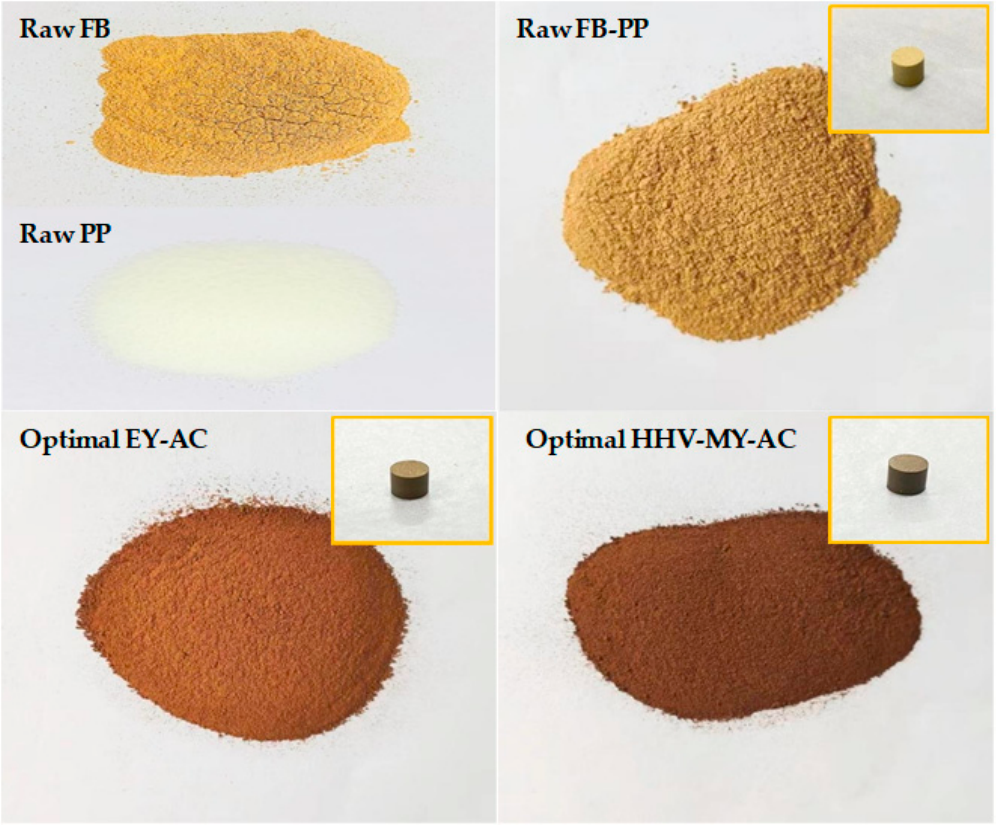
Figure 4. Images of raw fungal bran (FB), raw polypropylene (PP), raw FB-PP, optimal EY-AC, and optimal HHV-MY-AC.